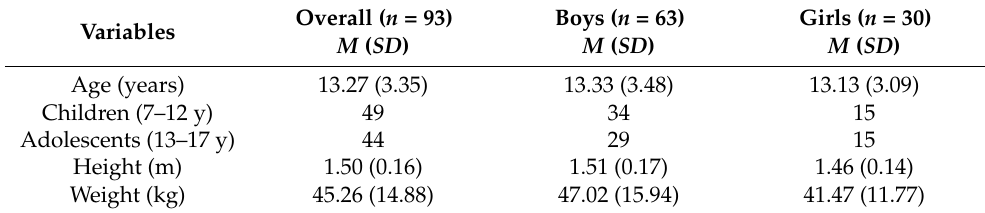
Table 1. Descriptive characteristics of the study sample.